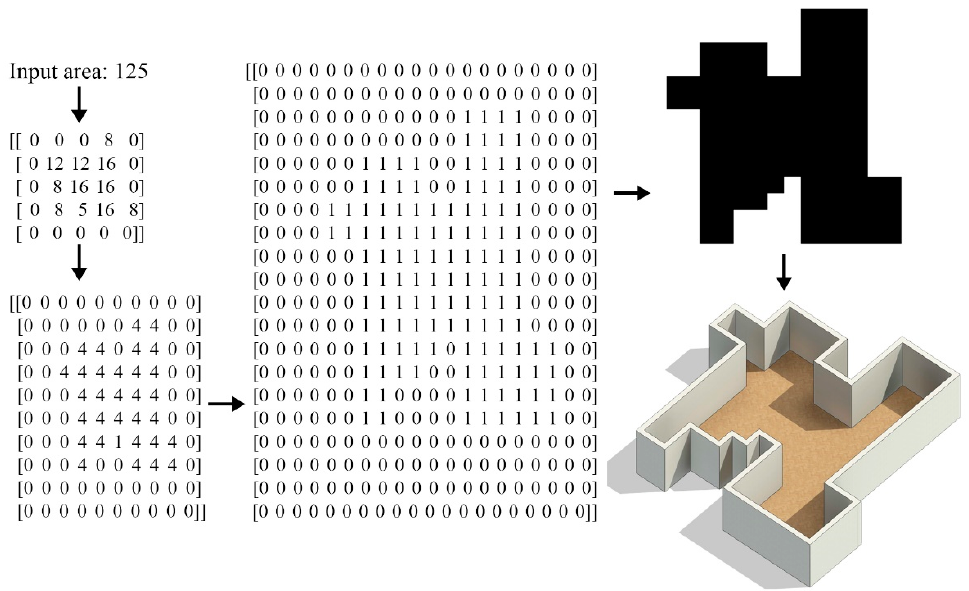
Figure 1. The illustration of an algorithm for one particular transformation starting with a 5 by 5 array (matrix), transformed to a 10 by 10 and finally a 20 by 20 array resulting in boundary rendered in 2D and also illustrated in 3D visual form.